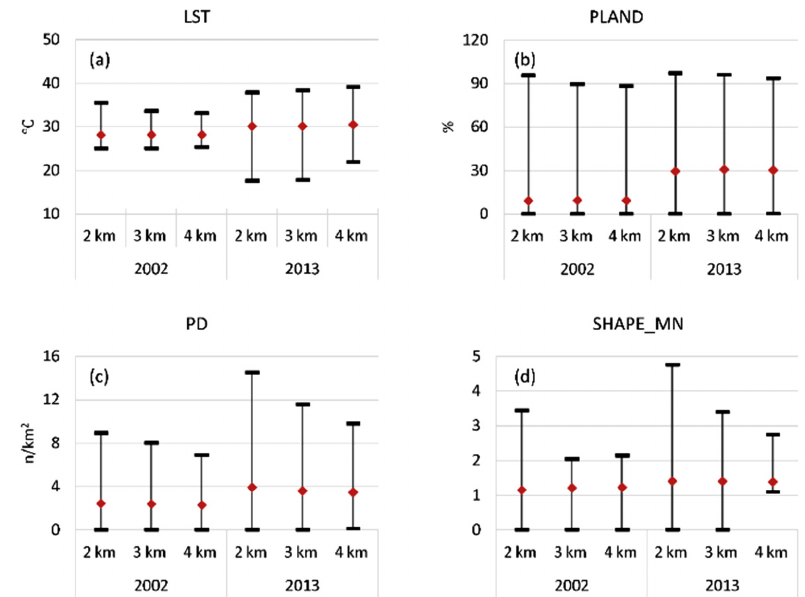
Figure 4. Maximum, minimum and mean value of variables at different spatial